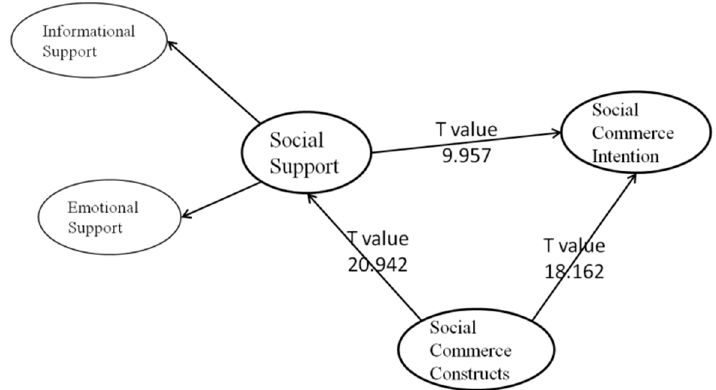
Figure 3. Results of bootstrapping implemented by the social commerce intention model.